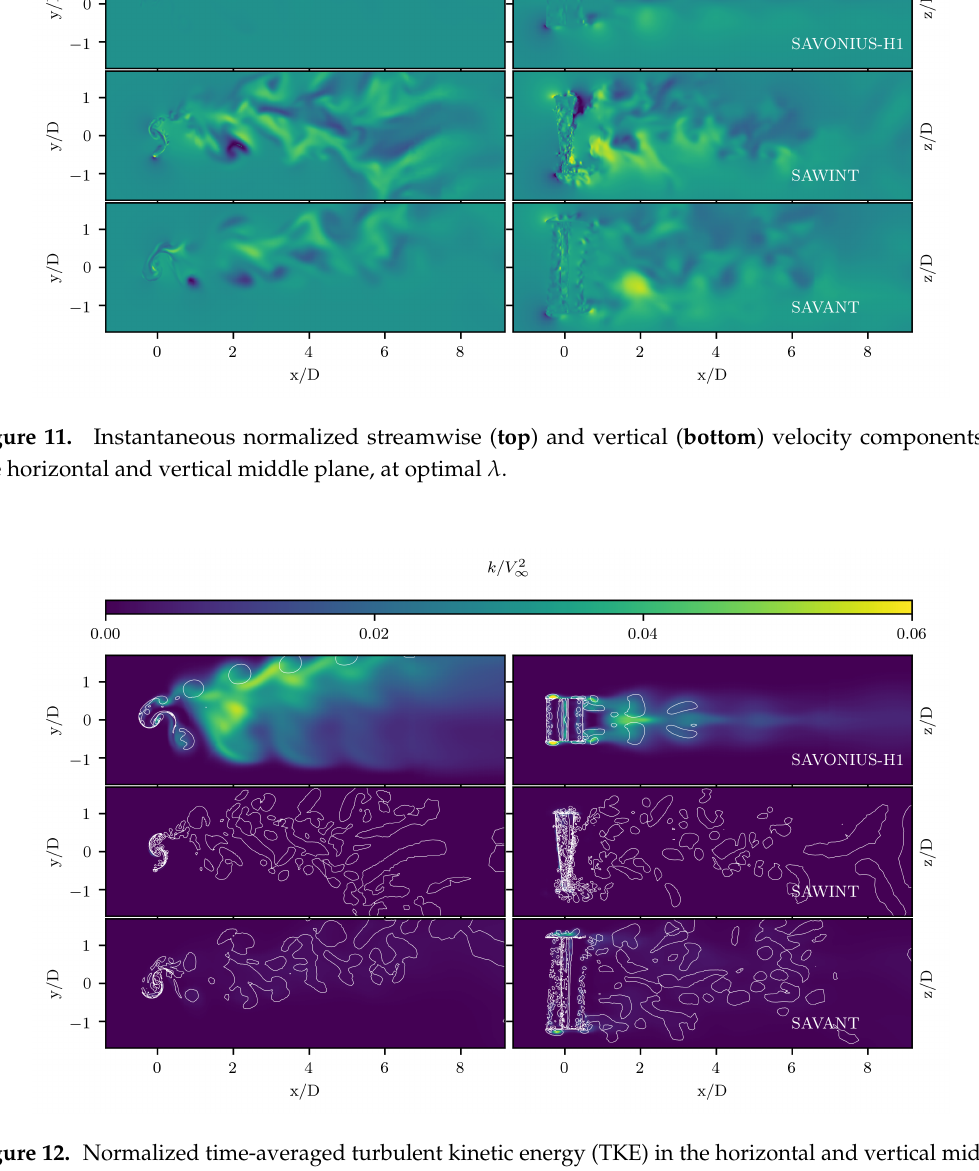
Figure 12. Normalized time-averaged turbulent kinetic energy (TKE) in the horizontal and vertical middle plane, at optimal λ . The isolines represent a Q-value of